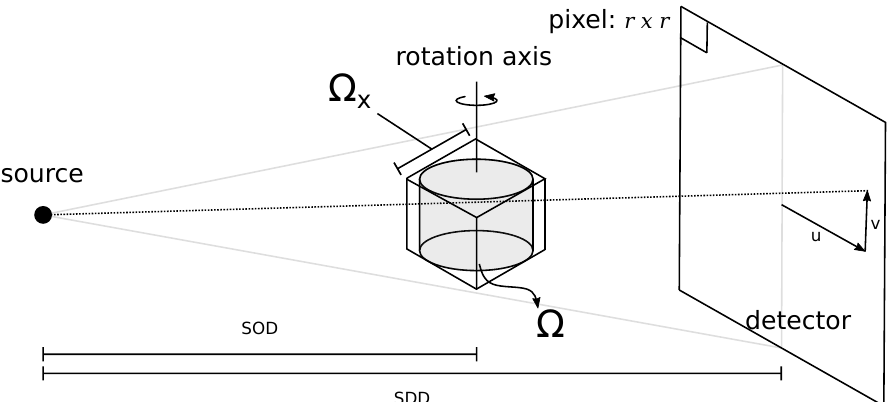
Figure 1. A schematic overview of the cone-beam geometry. The object is mounted on a rotation stage at distance SOD from the source. The object is supported on Ω , and the voxel grid x is supported on Ω x . The detector is at distance SDD from the source and is divided into N u × N v pixels of size r × r . We use the coordinates ( u , v ) to denote a location on the